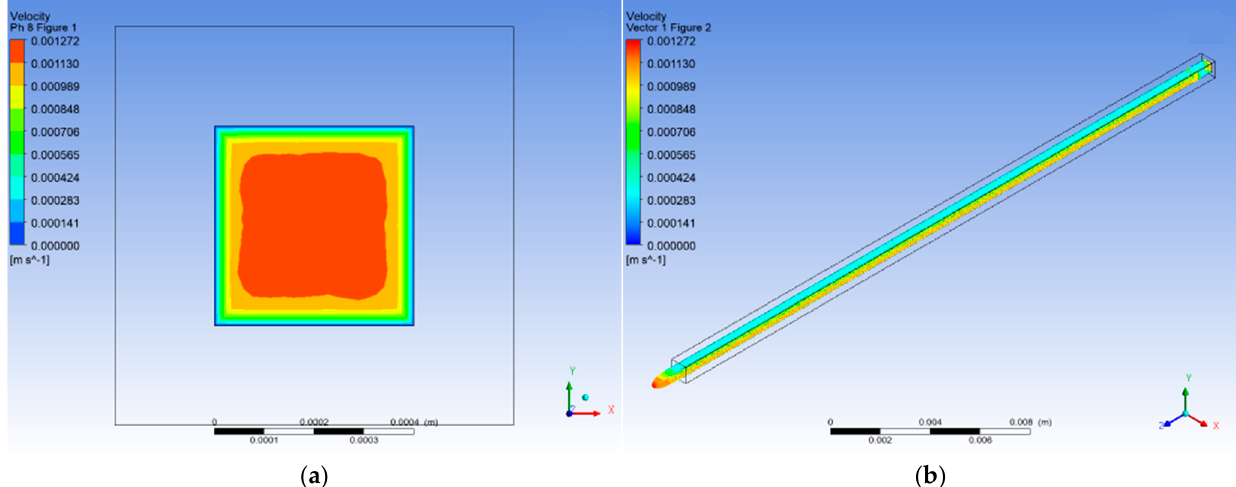
Figure 12. CFD numerical analysis results (pH 8): ( a ) contour; ( b ) vector.